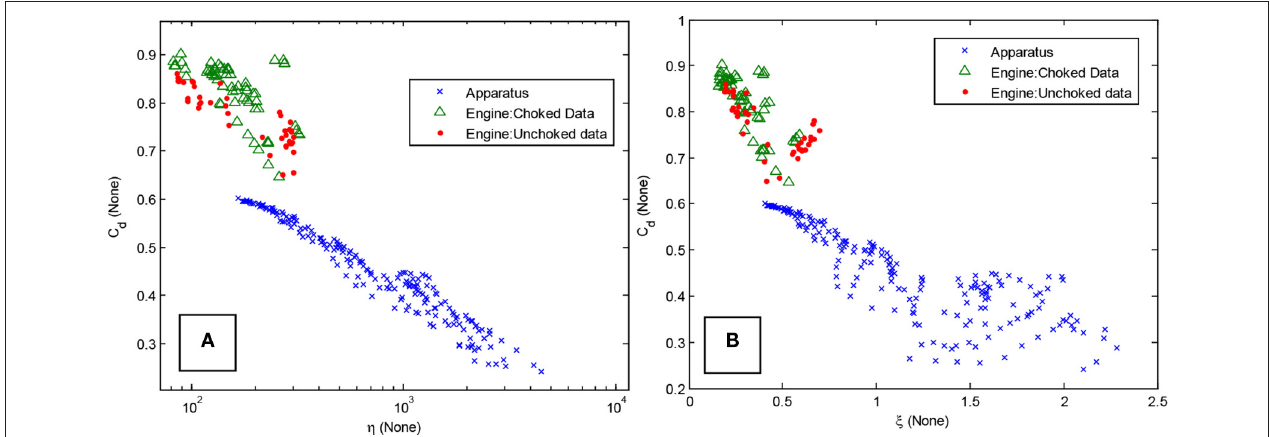
FIGURE 12 | (A,B) Data from both systems plotted against η and ξ illustrates the strong